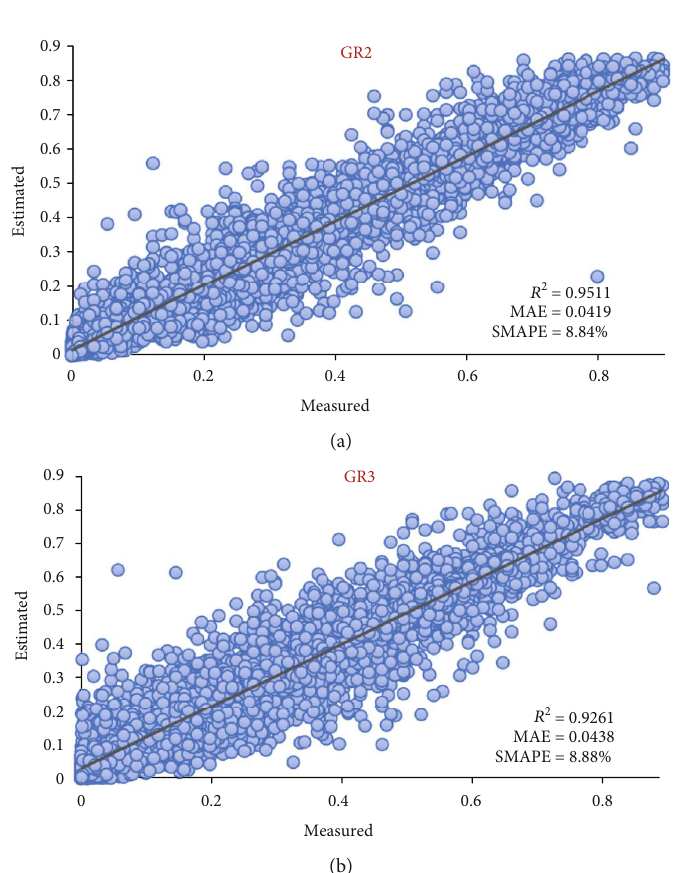
Figure 13: Scatter plots of a KNN-based most successful models according to the (a) GR2 input data for Kahramanmaras and (b) GR3 for Isparta.